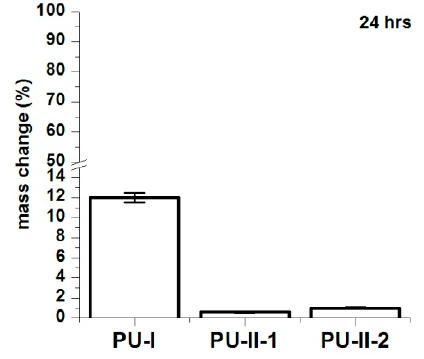
Figure 4. Canola oil sorption noted for PU-I, PU-II-1, PU-II-2 after 24 h of incubation.